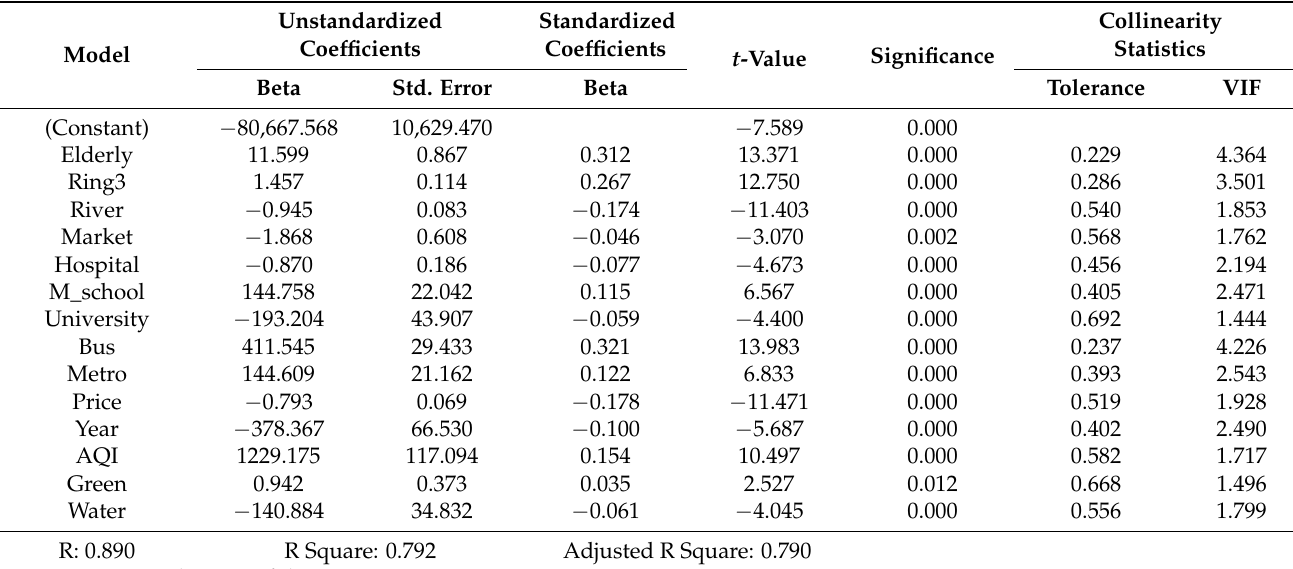
Table 7. Model summary of fourteen urban